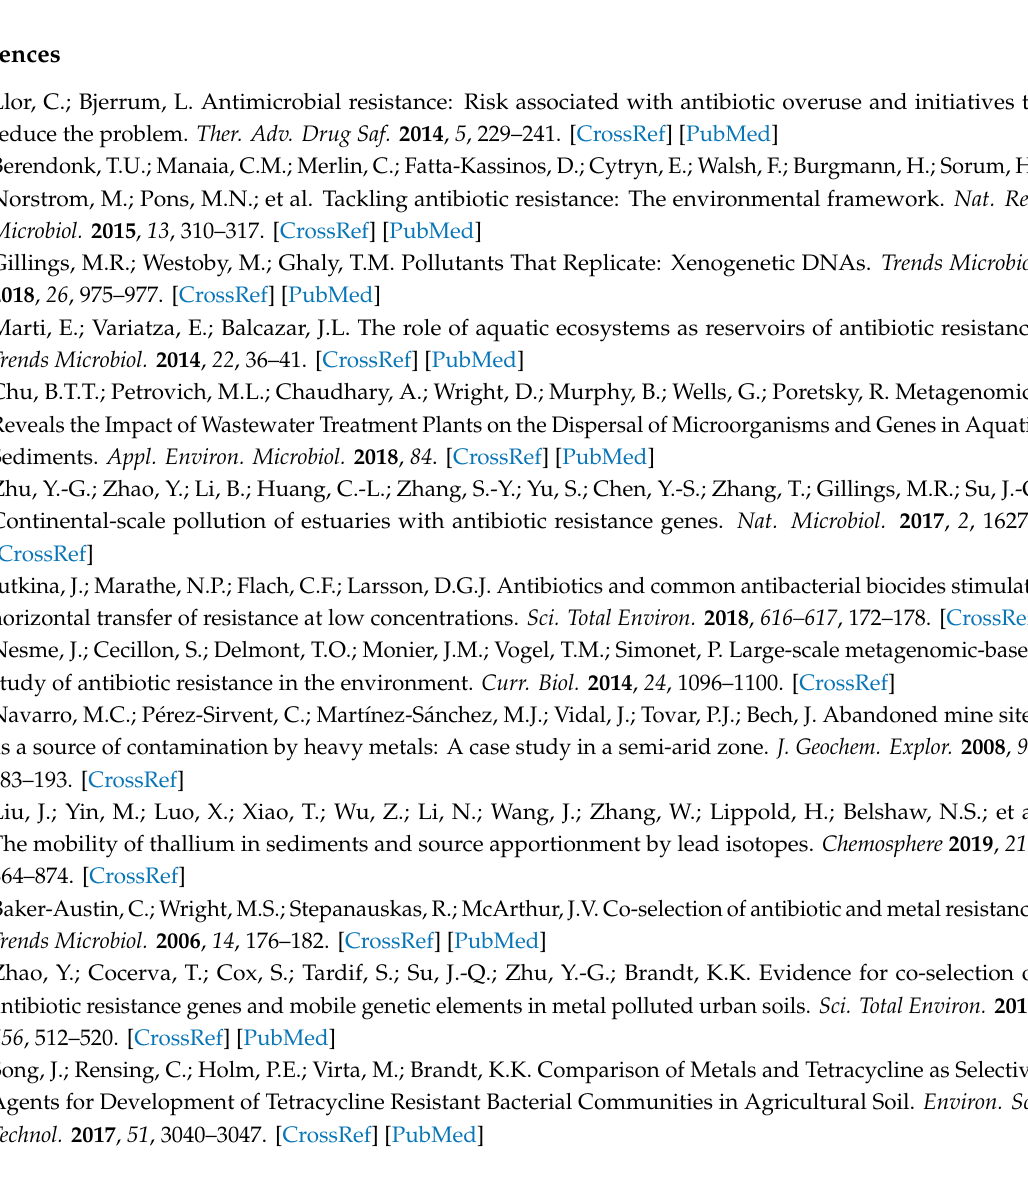
Figure S1: Plasmid-containing the construct with ARGs. Table S1: List of ARG included in the qPCR array of Qiagen, All data is available online as supplementary information: S1